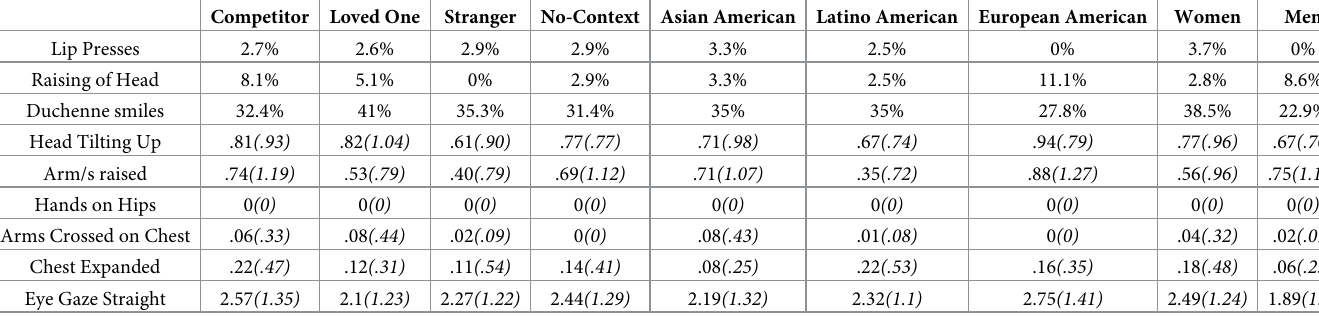
Table 2. Percentages and mean ( SD ) values for nonverbal displays by social context, ethnic heritage, and gender. Competitor Loved One Stranger No-Context Asian American Latino American European